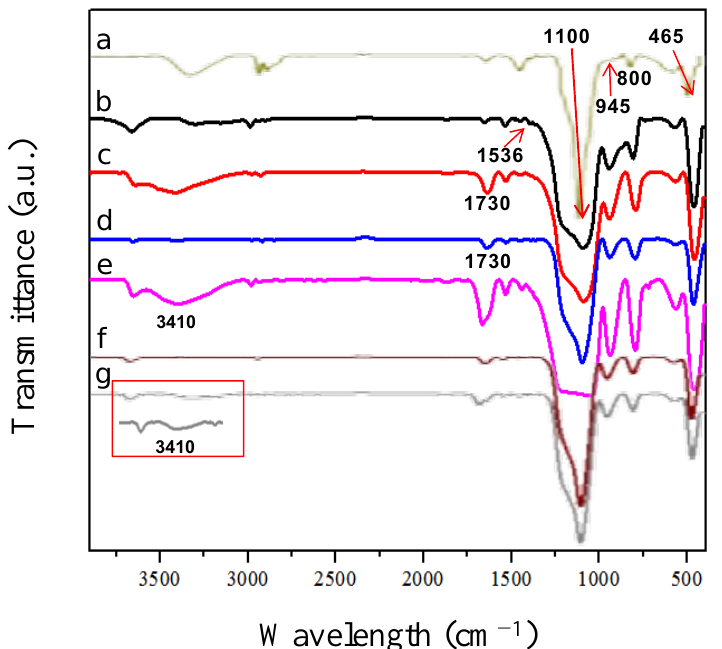
Figure 2. FT-IR spectrum of SiO 2 (a), SiO 2 -Br (b), SiO 2 - g -POEGMA (c), SiO 2 - g -PtBA (d), SiO 2 - g -PAA (e), SiO 2 - g -P(OEGMA 50 - stat -tBA 50 ) (f), SiO 2 -g-P(OEGMA 50 - stat -AA 50 ) (g).